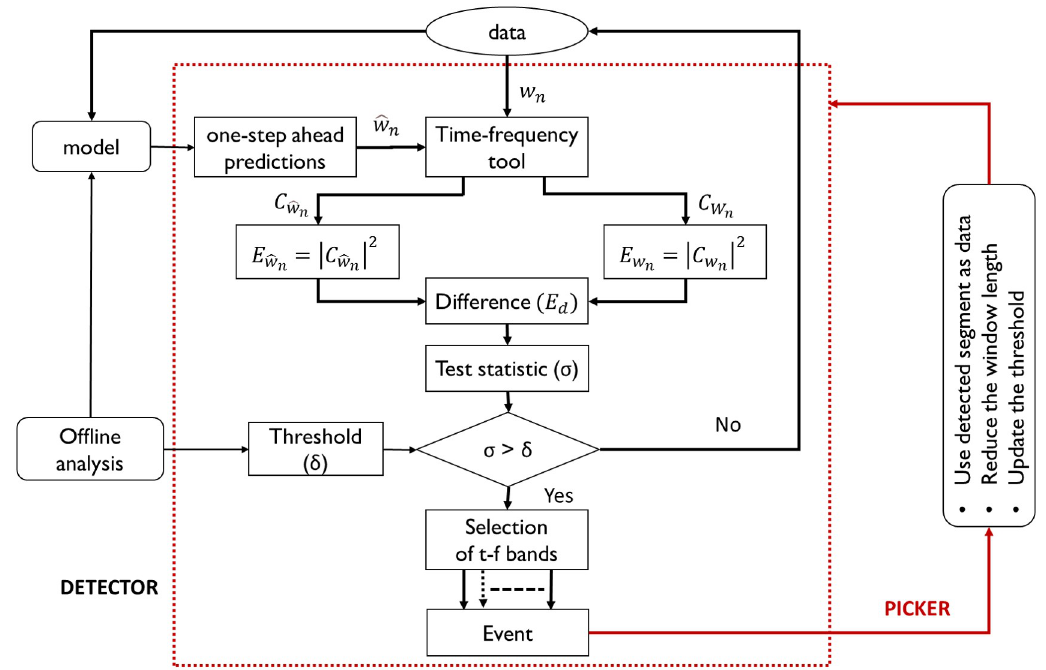
Fig 1. Proposed framework for P-wave detection and picking that accommodates any modeling technique (for prediction) and a t-f tool (for